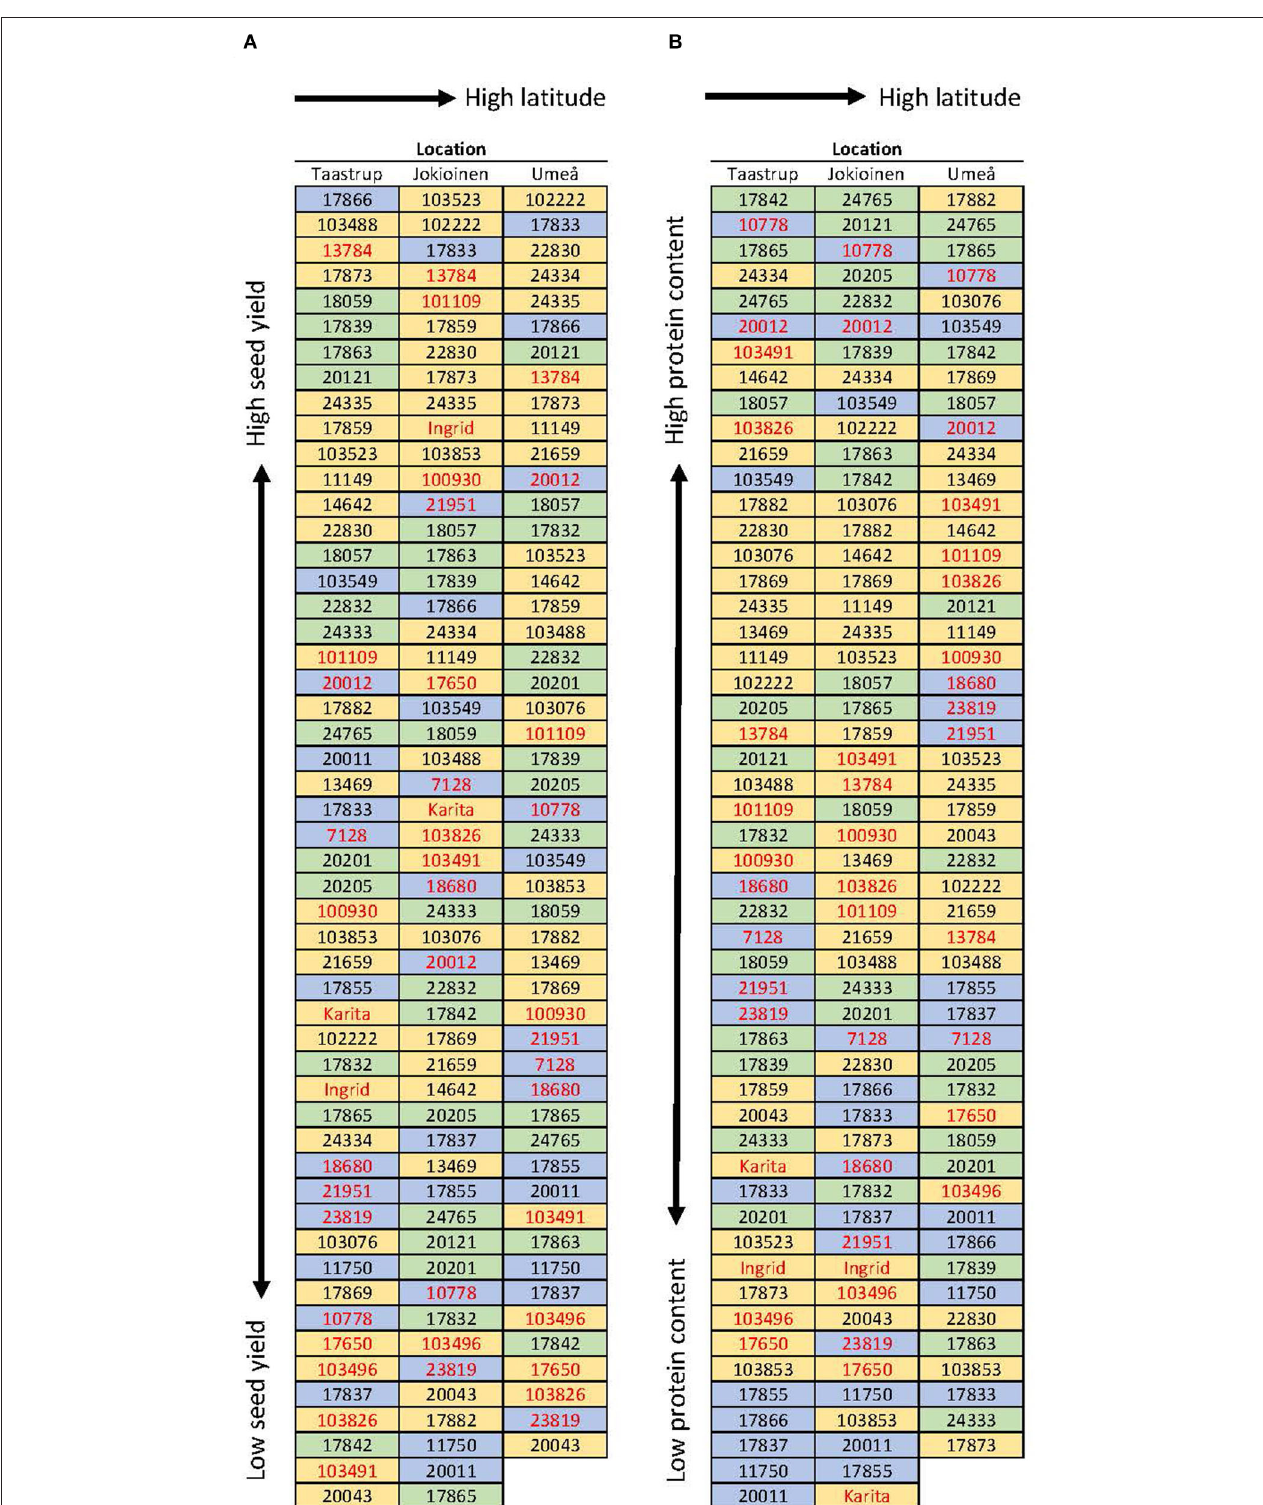
FIGURE 5 | Ranking of accessions regarding (A) seed yield gram per plant and (B) protein percent. The values are based on the average of 2 years (2018 and 2019) except for Umeå, which is based on values obtained for the year 2018 alone. The blue background represents the sugar pea, the green represents the shelling pea, and the yellow background represents the field pea. Cultivars and breeding lines are shown in red, the rest are landraces.